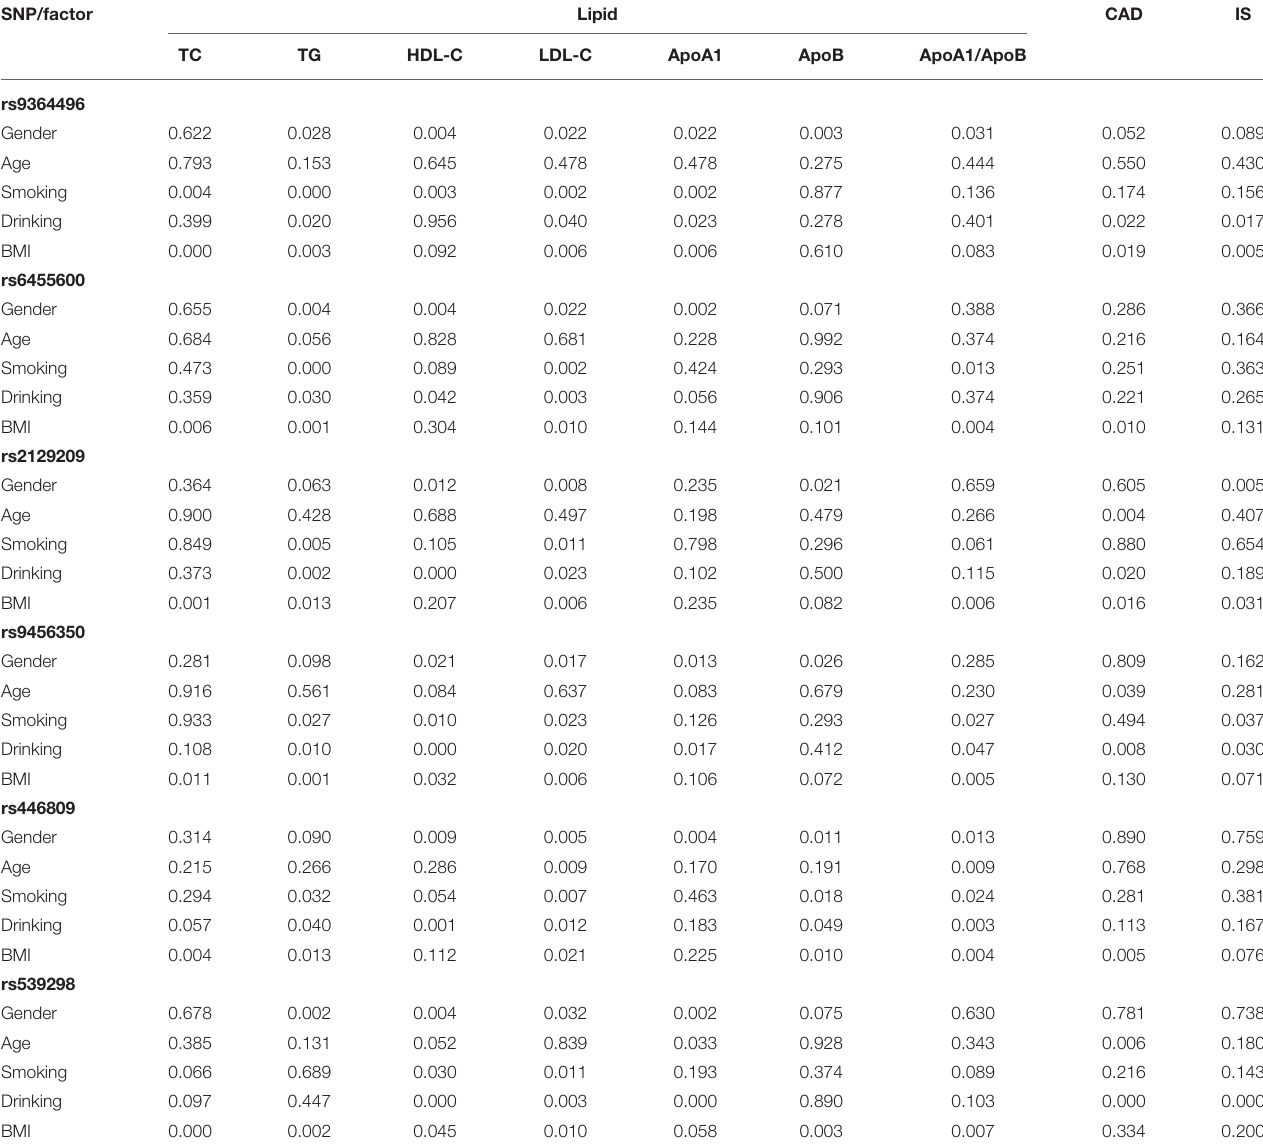
TABLE 5 | The P -values for the interactions of genotypes and gender, age, drinking, smoking, and BMI on serum lipid levels and the risk of CAD and IS. SNP/factor Lipid CAD